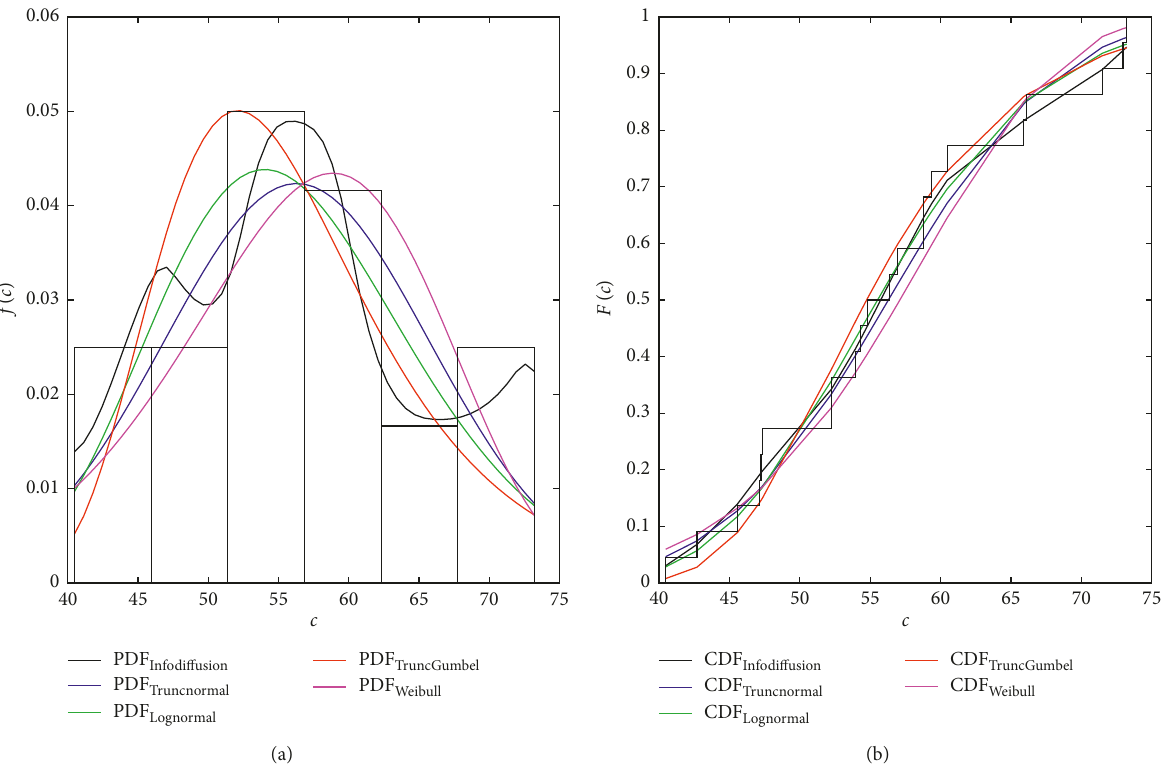
Figure 6: PDFs and CDFs of c under different marginal distribution types.